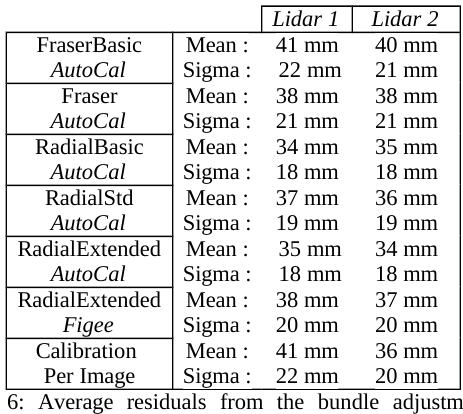
Table 6: Average residuals from the bundle adjustment in different scenarios